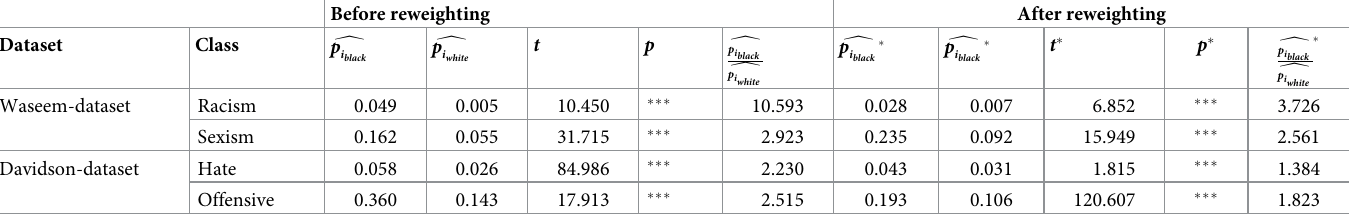
Table 4. Racial bias analysis before and after reweighting the training data. To quantify the impact of the re-weighting mechanism in alleviating the racial bias propa- gated through trained classifiers, we examine our BERT-based classifiers trained on Waseem and Davidson datasets with and without re-weighting mechanism on AAE- aligned and SAE-aligned